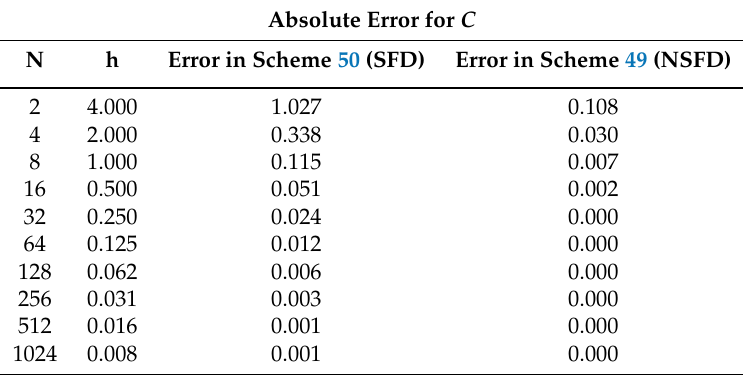
Table 1. The absolute error results of Equations (43) for C with parameters values R = 0.5, K m = 4, and V max =